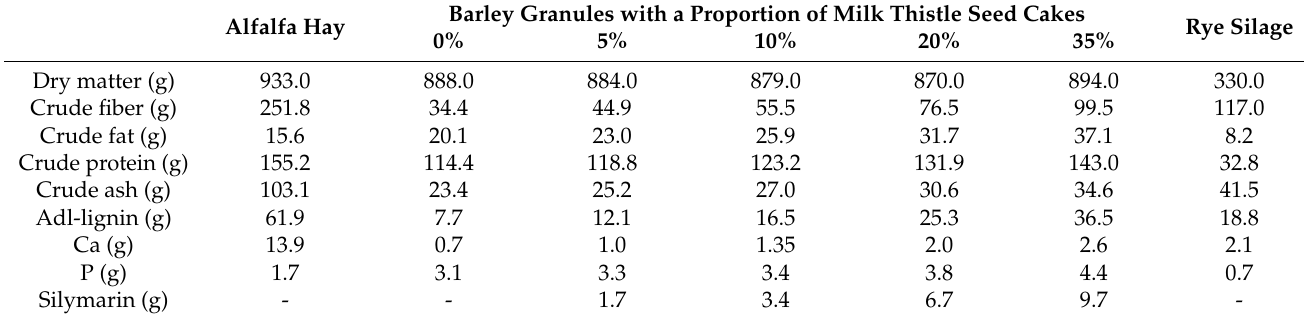
Table 2. The nutrient composition of feed forming the basic feed dose of horses.